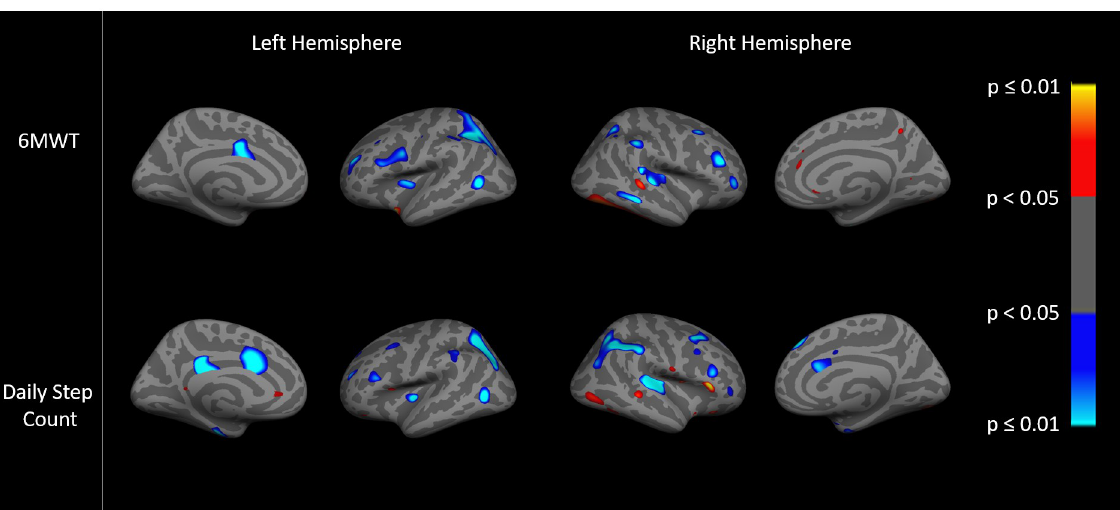
PLOS ONE | https://doi.org/10.1371/journal.pone.0254653 July 15,